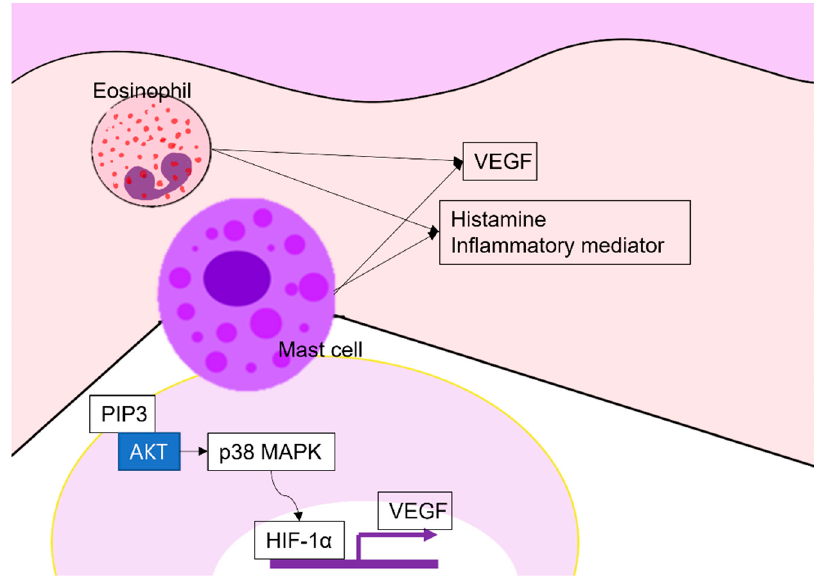
Figure 4. Angiogenesis in chronic urticaria: Eosinophils and mast cells produce VEGF, histamine, and other inflammatory mediators. Especially, mast cells produce VEGF via the PI3K/Akt/p38 MAPK/HIF-1 α signaling pathway. VEGF, vascular endothelial growth factor; PIP3, phosphatidyl inositol 3,4,5 tri-phosphate; HIF, hypoxia-inducible factor-1.